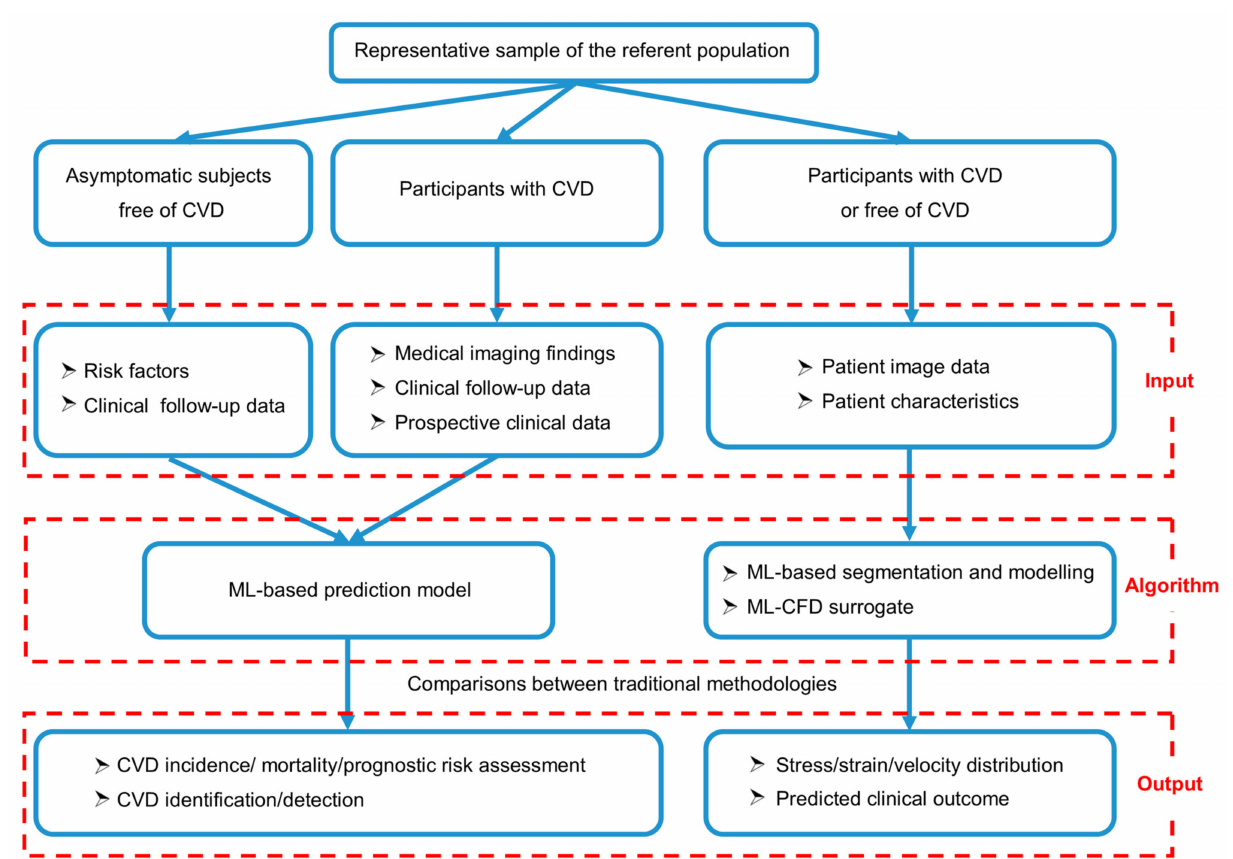
Figure 3. Two types of machine learning − based approaches were applied to evaluate cardiovascular disease